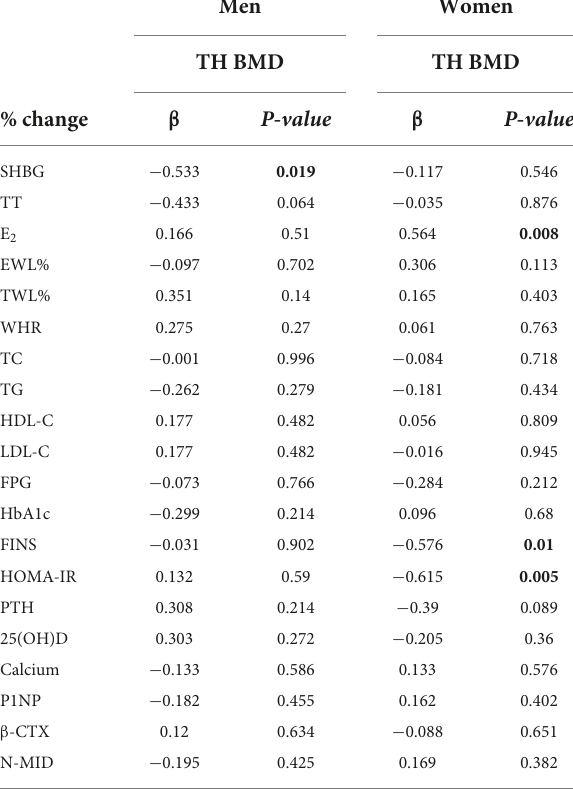
TABLE 3 Correlation analysis between percent change between clinical and bone metabolic